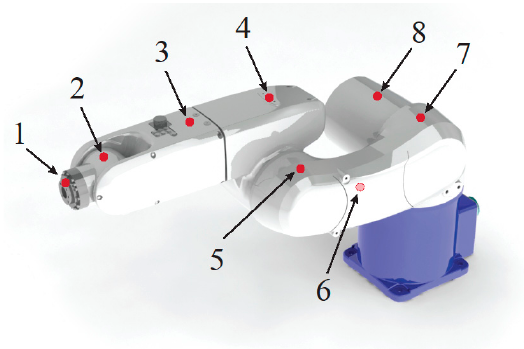
Figure 6. Measurement points for modal testing.